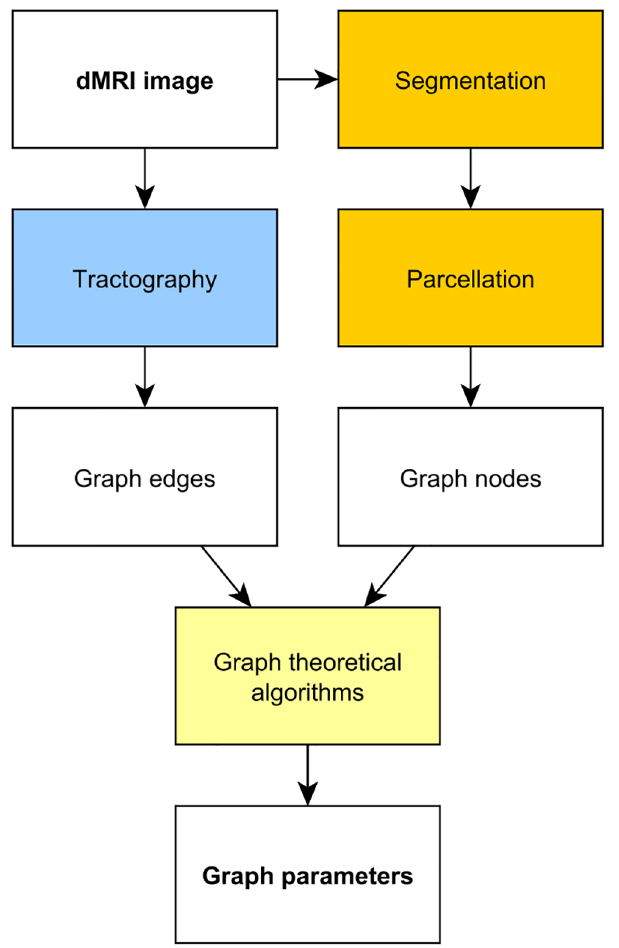
Fig 2. The block diagram of the workflow presented. The phases are detailed in the “ Methods ”